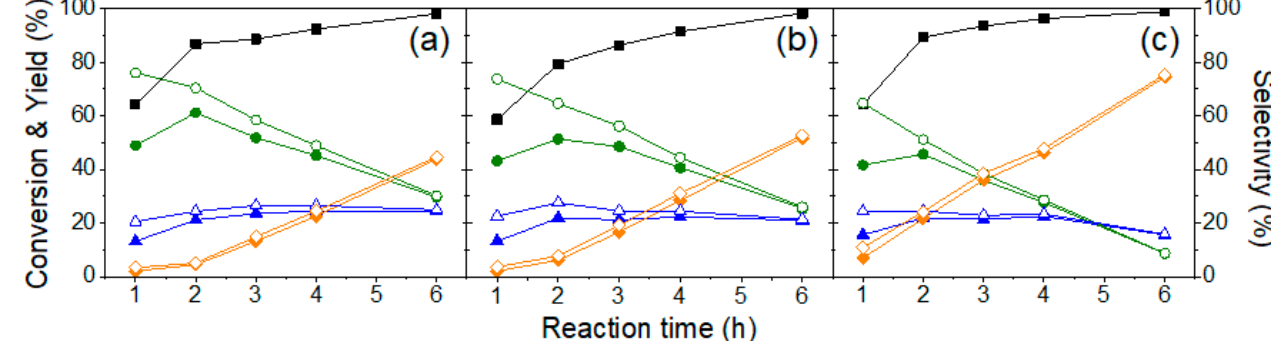
Figure 6. The influence of reaction time on the etherification reaction of glycerol: ( a ) XZ-Li, ( b ) XZ-Na and ( c ) XZ-K (- ■ -: conversion of glycerol, - ● -: yield of DG, - ▲ -: yield of TG, - ♦ -: yield of others - ○ -: selectivity of DG, - Δ -: selectivity of TG, - -: selectivity of others, amount of zeolite: 3 wt.%, reaction temperature: 280 °C).